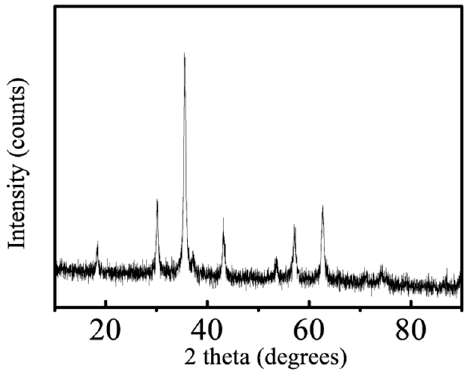
Figure 5. XRD analysis diagram of the Fe 3 O 4 -PDA-SO 3 H.